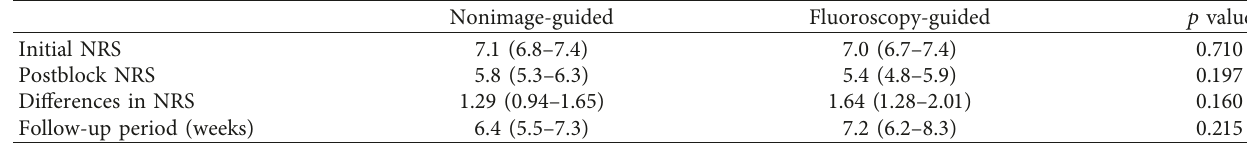
Table 2: Differences in pain intensity between blind and fluoroscopy-guided interlaminar lumbar epidural block in the same individuals.